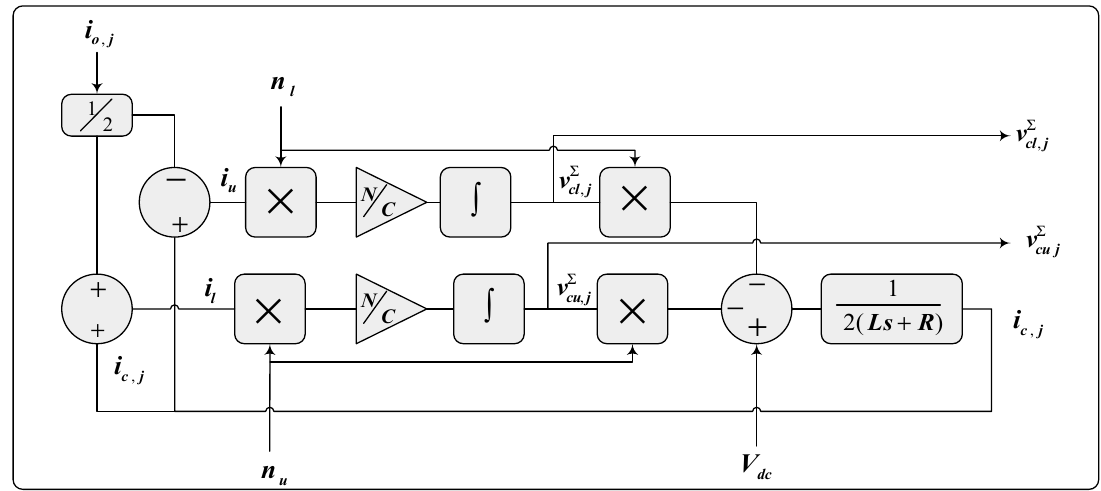
Figure 3. Simulink Figure 3 . Simulink model .